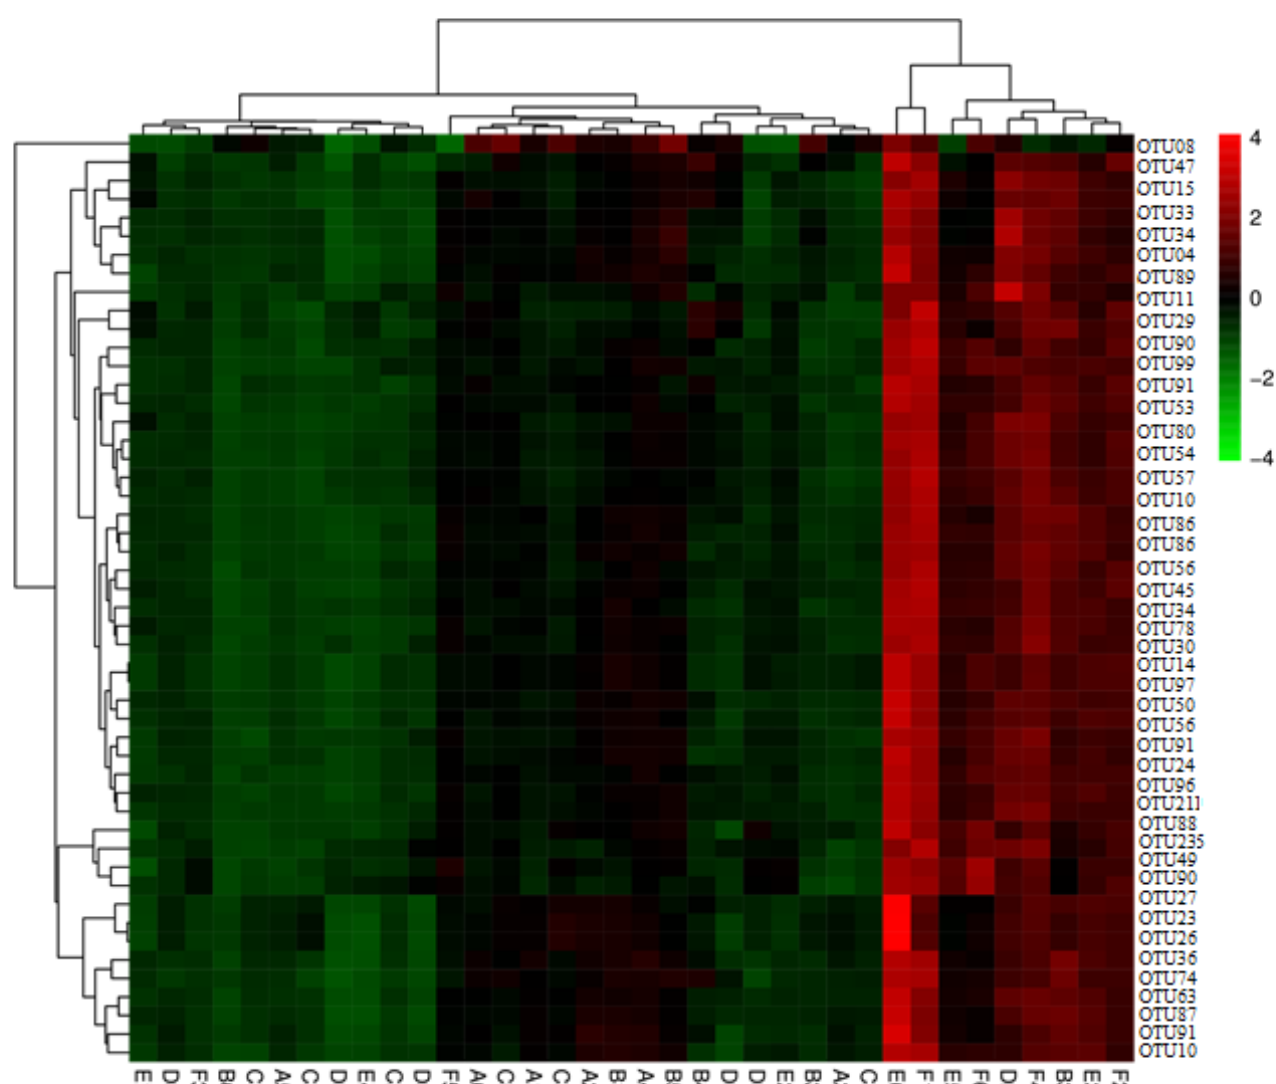
Figure 4. Clustering analyses of cecal samples. Birds were fed with two main diets, corn diet supplemented with (A) enzyme-a, (B) enzyme-b and (C) enzyme-c and wheat diet supplemented with (D) enzyme-a, (E) enzyme-b, and (F) enzyme-c and 10% flaxseed. Cecal samples were collected at day 70 of feeding for analyses of microbiota by using 16S rDNA sequence richness.